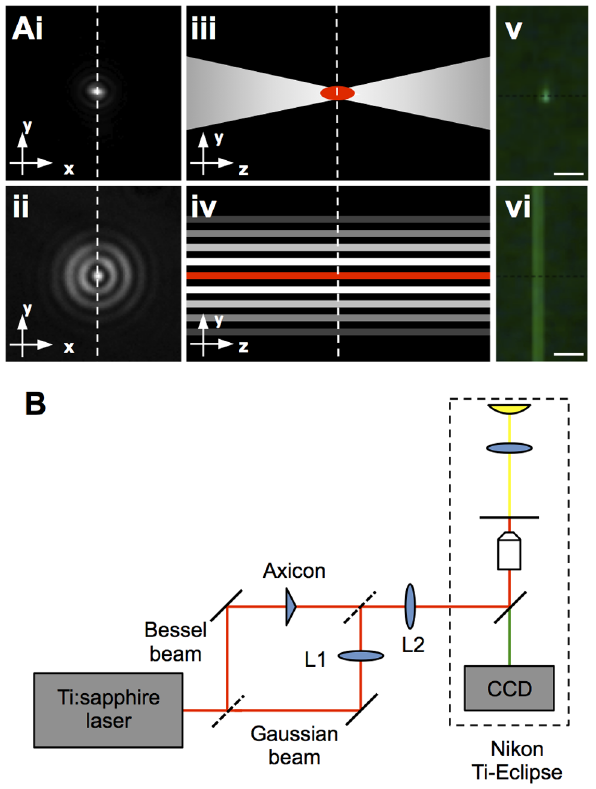
Figure 1. Optical set-up applied for plant cell photoporation. A provides a series of schematics depicting Gaussian and Bessel beams. The first column shows example microscope images of transverse profiles of focused Gaussian (i) and Bessel (ii) beams. Illustrative axial profiles are seen in iii and iv where the regions of multi-photon absorption are shown in red. The Bessel beam axial extent of multi- photon absorption is much longer than that of the Gaussian. The white dotted lines show the corresponding cross-sections of the orthogonal images. The final column experimentally shows two-photon excitation of fluorescein of each beam adapted from [30], scale bars represent 100 m m. Laser setup is shown in B. Output from the laser was directed into either of two arms using a removable mirror, denoted by dotted lines. A Bessel beam was generated using an axicon and a Gaussian beam spot was created using a system of telescopes (L1 and L2). The beam paths were directed into the back of a commercial inverted microscope where all imaging was